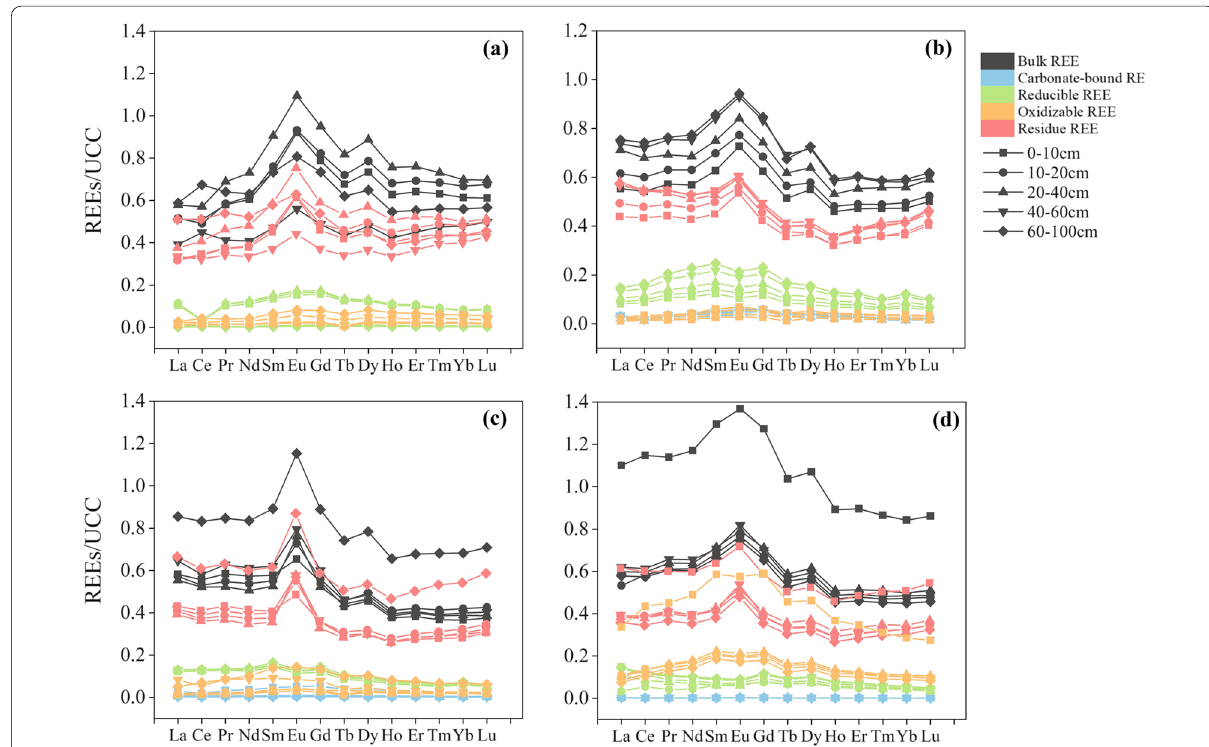
Fig. 5 Upper continental crust normalized patterns of carbonate‑bound REE, reducible REE, oxidizable REE, and residue REE in soil depth profiles